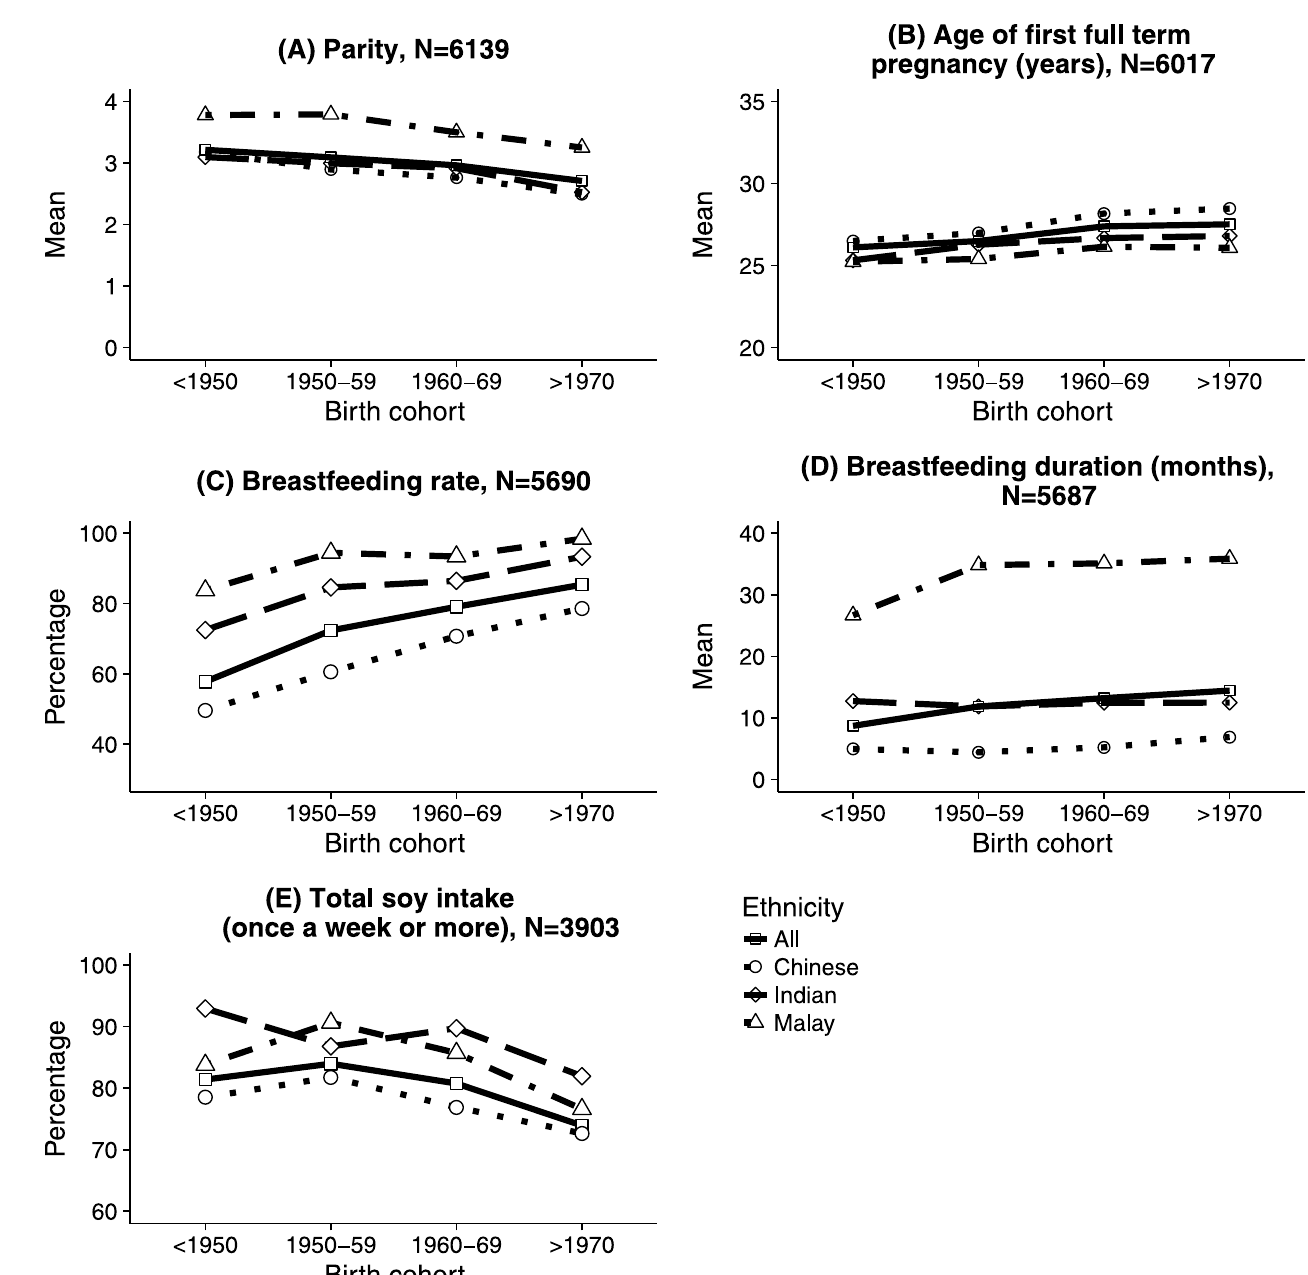
Fig 1. Change of breast cancer risk factors across birth